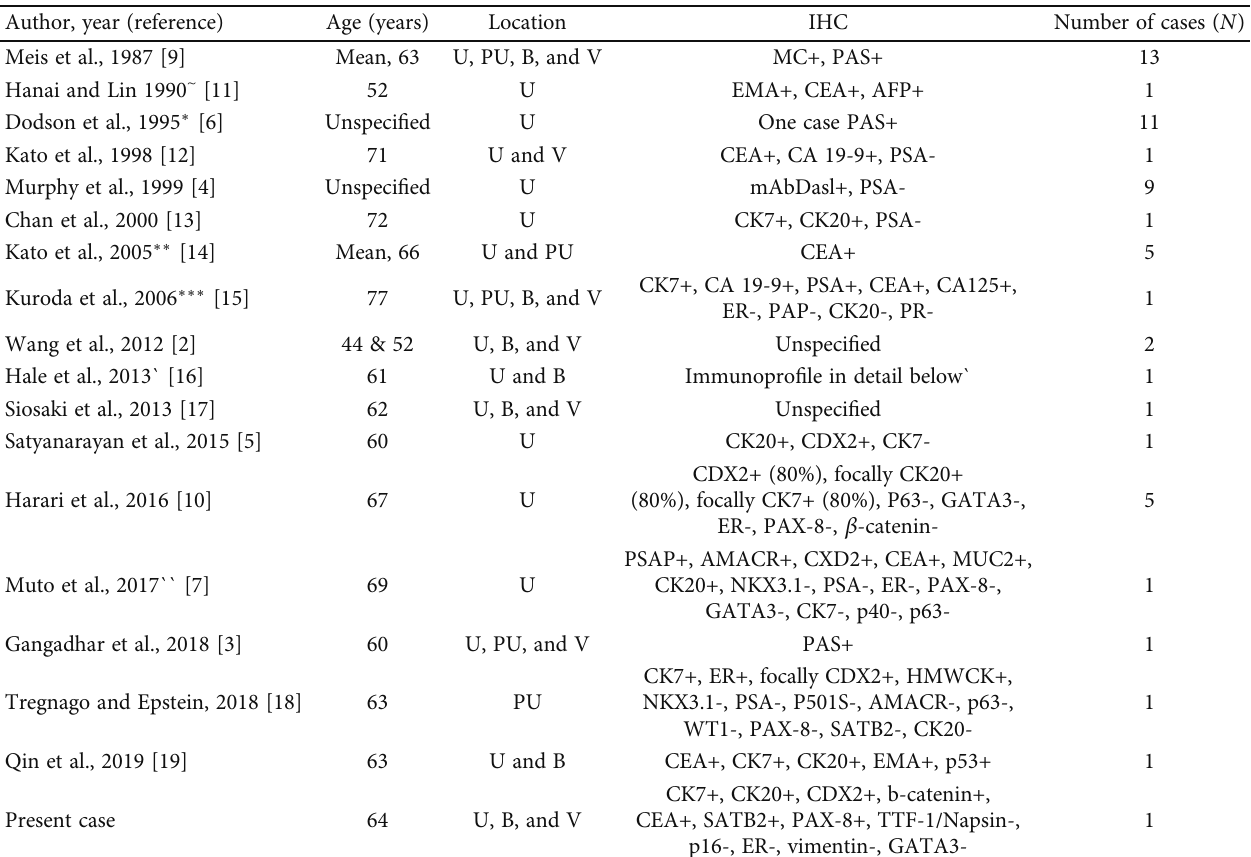
Table 1: Demographic and immunohistochemical pro fi les for primary female urethral adenocarcinomas, columnar/mucinous subtype reported in the